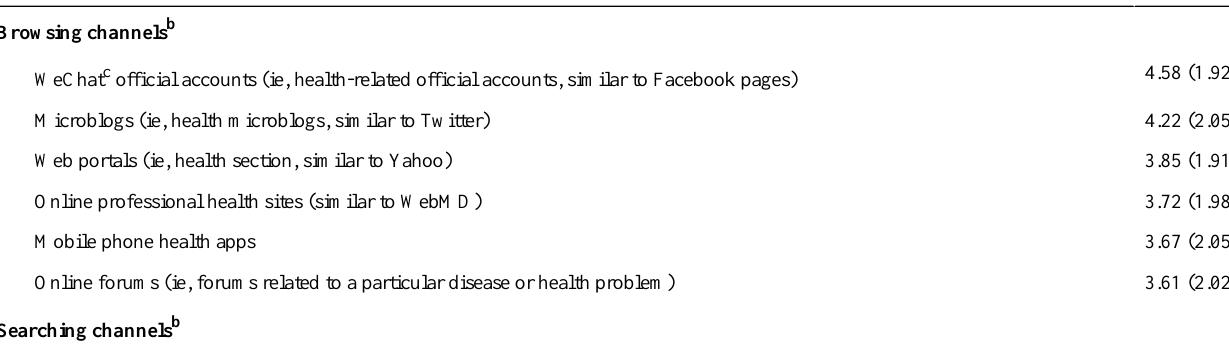
This study measured 7 RISP predictors. Table 2 lists specific survey question items and their descriptive